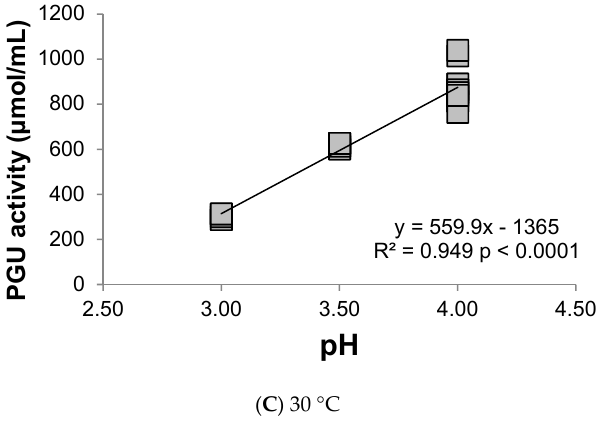
Figure 1. Impact of pH on polygalacturonase (PGU) activity in Scottzyme Color X (temperature = 15, 20, 30 °C; ethanol = 0%), measured in sodium acetate buffer solution.